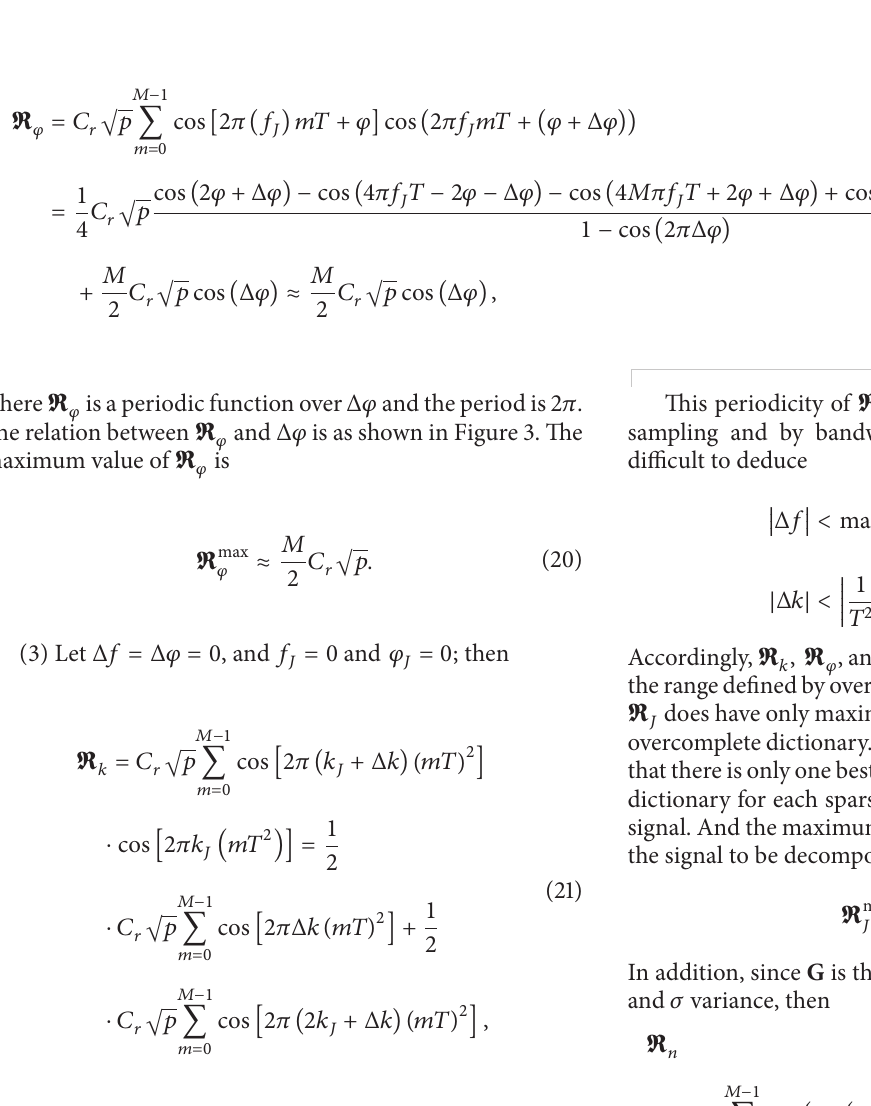
Figure 2: Relation between R 𝑓 and Δ𝑓